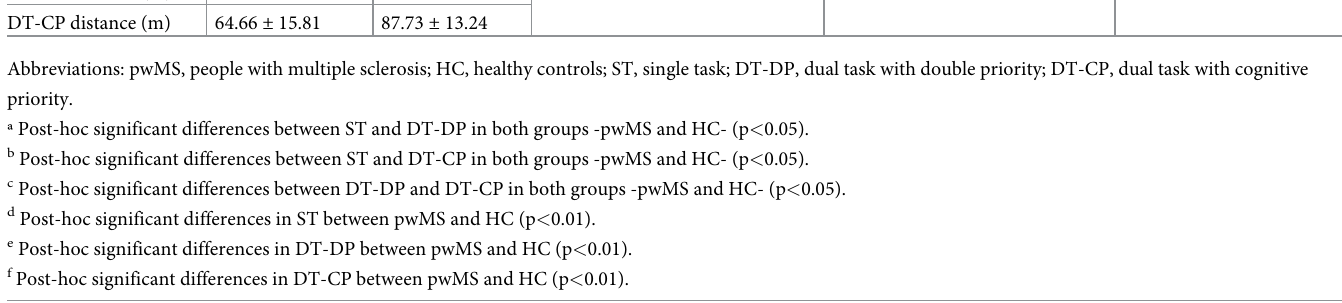
no differences were found in cognitive DTC of DT-DP vs DT-CP in any of the groups (pwMS: p < 0.58 and HC: p = 0.85).